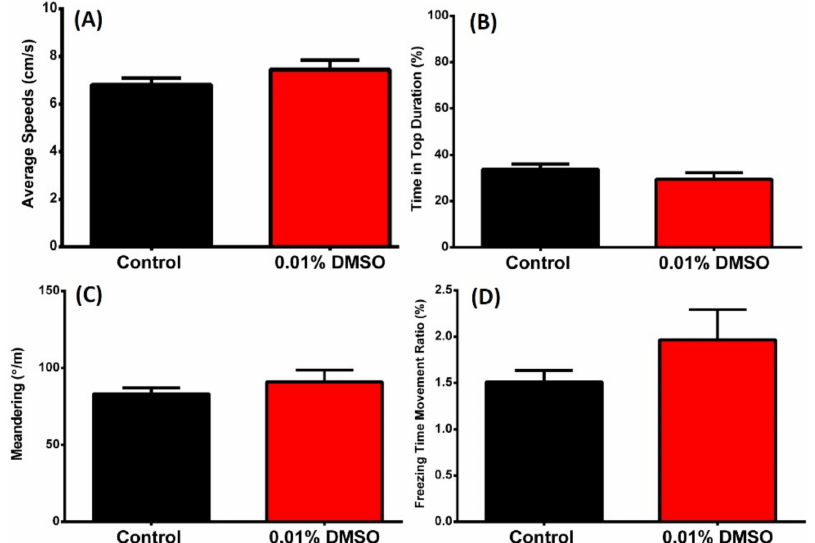
Figure A1. Comparison of behavior endpoints between control and 0.01% DMSO-exposed zebrafish in 3D (three-dimensional) locomotion test after five-day exposure. (A) Average speed, (B) Time in top duration, (C) Meandering, (D) freezing time movement ratio were analyzed. The data are expressed as the mean ± SEM and were analyzed by t -test ( n = 30 for control; n = 18 for 0.01% C 60 NPs-exposed fish).